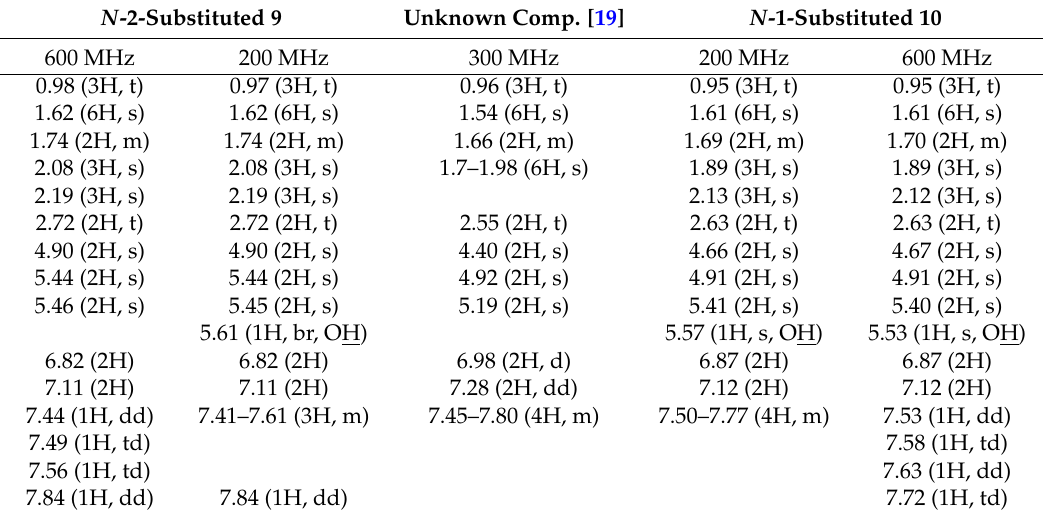
Table 3. 1 H Chemical shifts ( δ H /ppm) for the unknown compound [19] and compounds 9 and 10 of current work recorded in CDCl 3